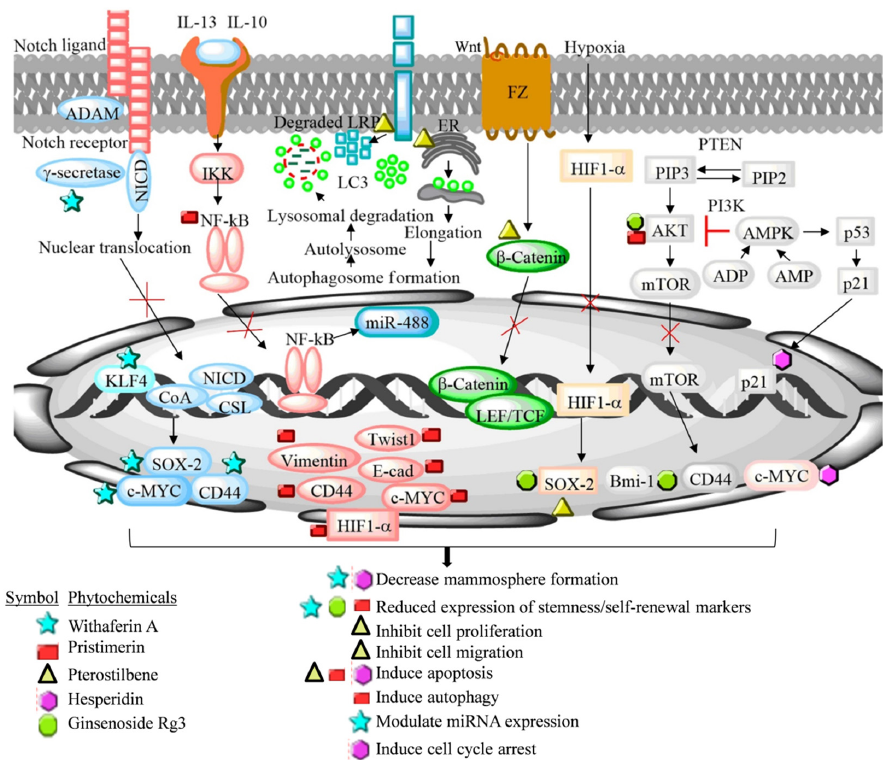
Figure 4. Luminal A-derived breast cancer stemness/self-renewal inhibiting potential of various di- etary phytochemicals including Withaferin A , Ginsenoside Rg3 (GRg3), Pterostilbene, Hisperidin, and Pristimerin. The phytochemicals target Notch signaling, Wnt, hypoxia, NF- ҡ B, and Akt path- ways involved in the maintenance of stemness and self-renewal. Withaferin A reduces the mam- mosphere formation in luminal A breast cancer cells by modulating the expression of Sox2, c-MYC, and CD44 via targeting Notch signaling pathway. Pterostilbene inhibits NF- κ B, vimentin, and Twist1, and elevated E-cadherin expression. Ginsenoside Rg3 inhibits the nuclear translocation of HIF-1 α , Sox-2, and Bmi-1 marker expression via targeting hypoxia and PI3K/Akt signaling pathway. Pristimerin mediated modulation of autophagy and degradation of LRP6, a Wnt co-receptor of Wnt signaling pathway and the expression of stemness markers. Hesperidin arrest cell progression at G0/G1 phase by targeting cyclin D1. Hesperidin modulates the expression of p21 and p53 in luminal A-derived mammosphere. [KLF4—Kruppel-like factor 4,